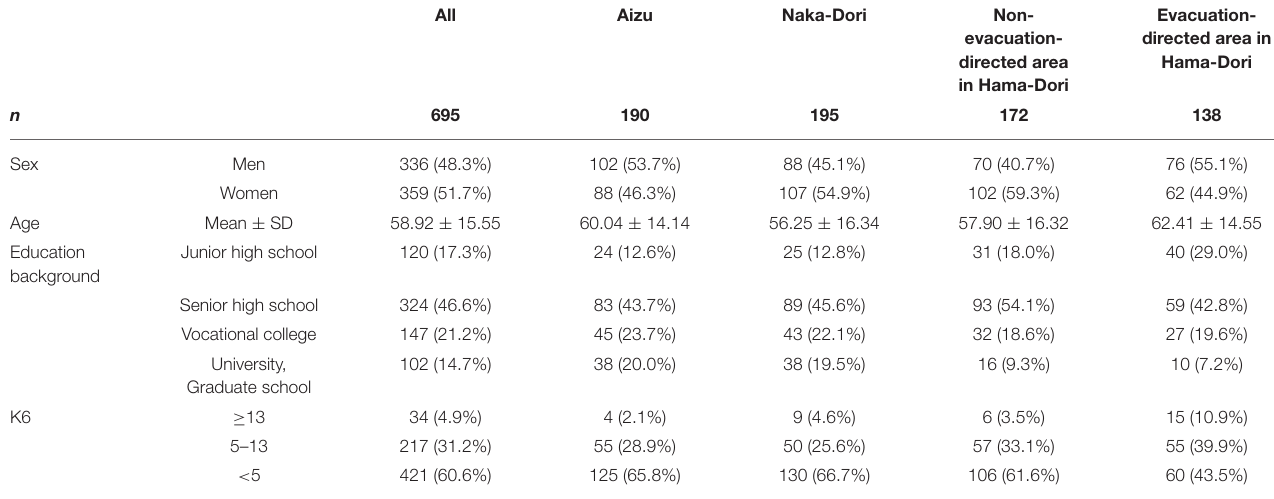
TABLE 1 | Demographic information of participants.